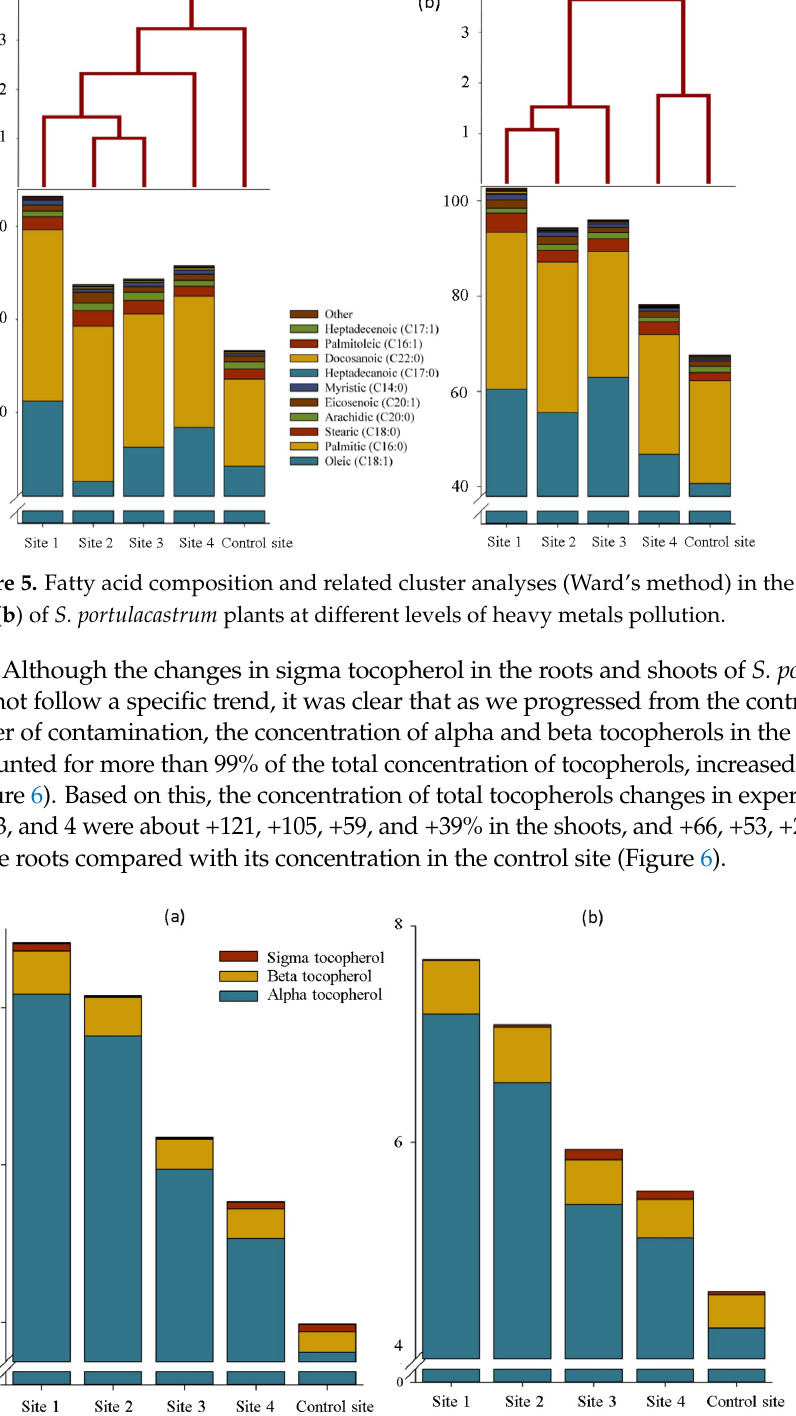
Figure 6. Tocopherols content in the shoot ( a ) and root ( b ) of S. portulacastrum plants at different levels of heavy metals pollution. Means in each tissue followed by similar letter(s) are not significantly different at 5% probability level (Tukey’s HSD test).